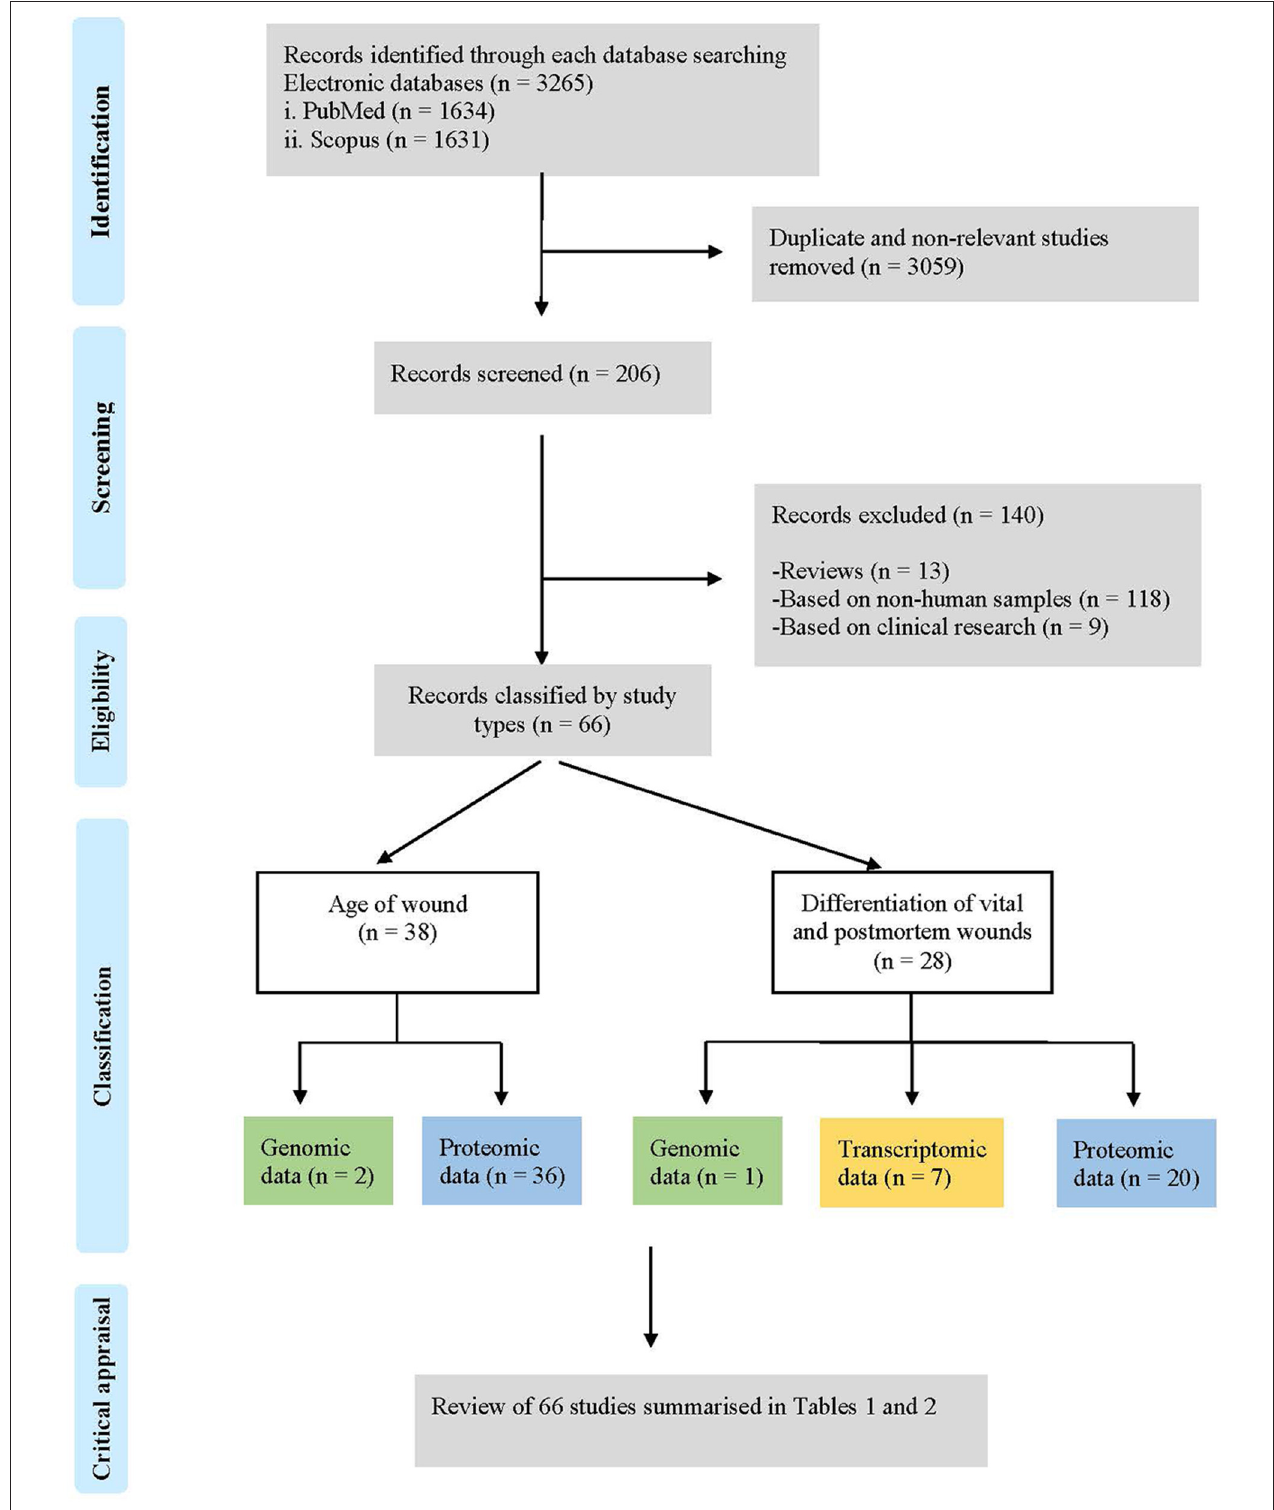
FIGURE 1 | Flow chart of the literature search process and study selection according to PRISMA (Preferred reporting items for systematic reviews and meta-analysis) guidelines.